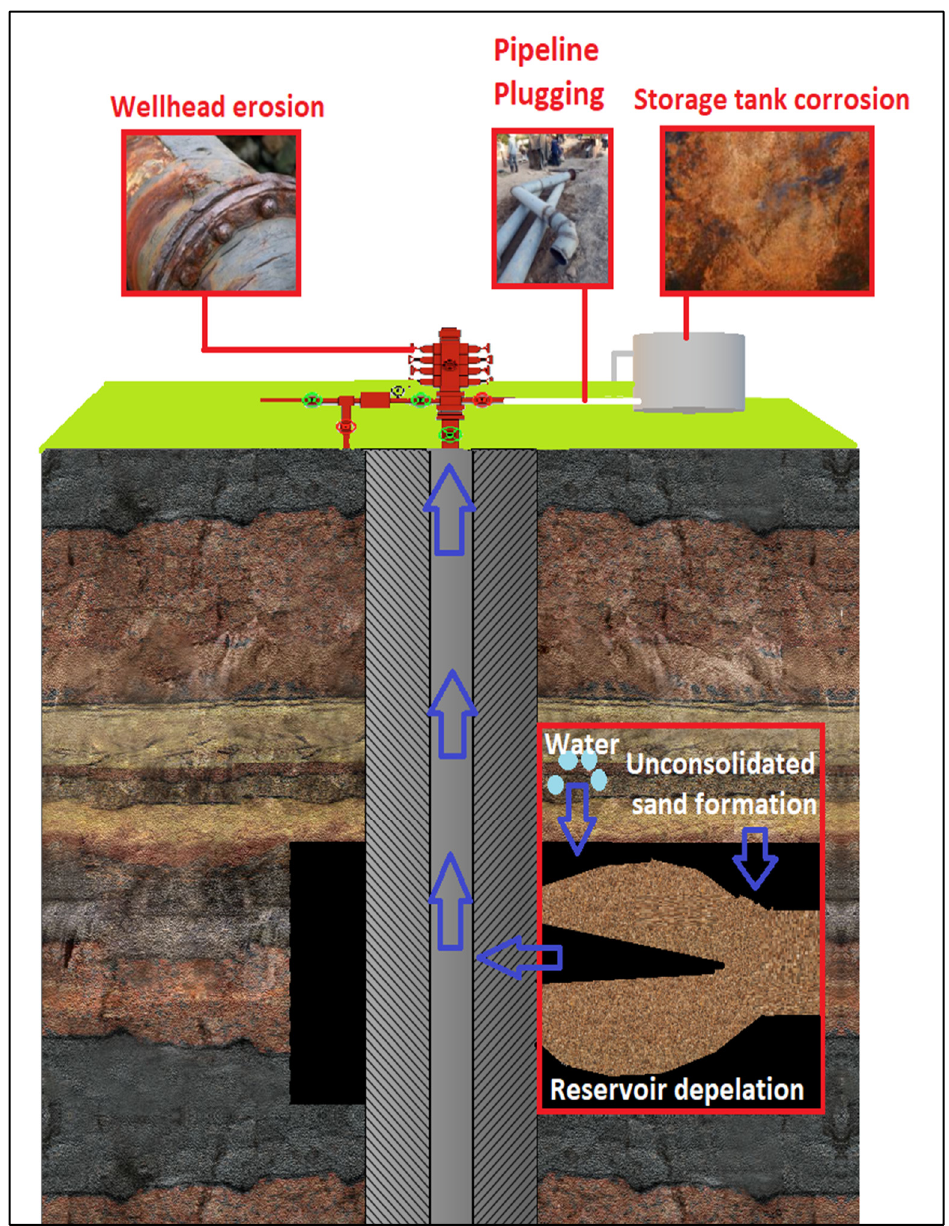
Figure 1. Causes and problems of sand production .